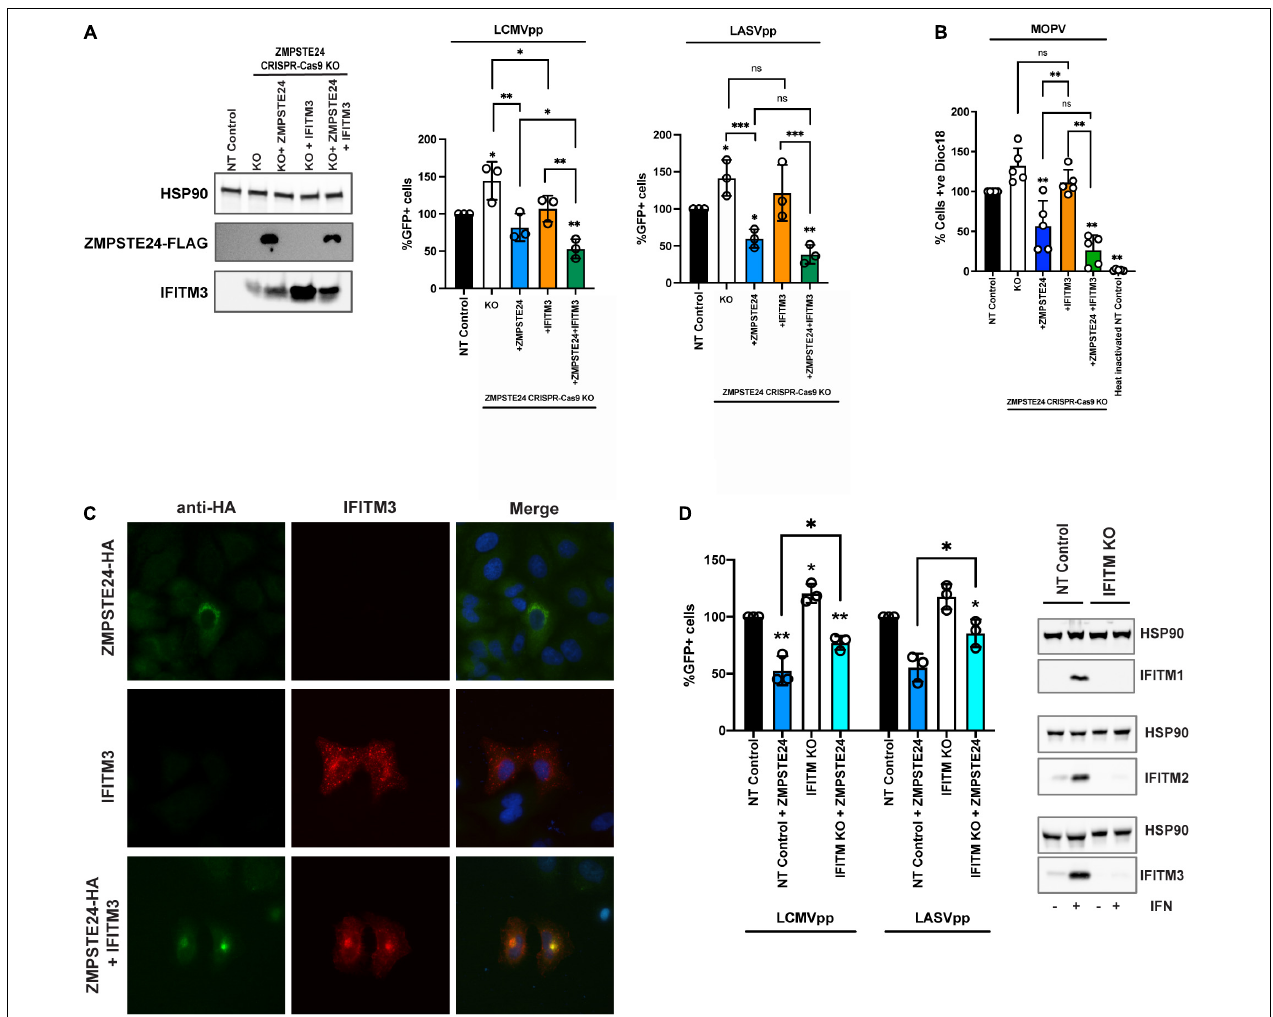
FIGURE 4 | ZMPSTE24 and IFITM3 co-operatively restrict arenavirus infection. (A) A549 CRISPR-Cas9 stable knock out cell lines were generated for non-targeting (NT) control or ZMPSTE24 and then transduced for stable overexpression of ZMPSTE24-FLAG or IFITM3 or both. Stable expression was confirmed by western blot cells were then infected with LCMVpp or LASVpp and% infection was measured by flow cytometry analysis of GFP expression. (B) Cells from panel A were infected with SP-DiOC-18 labelled MOPV for 1.5 h. SP-DiOC18 positive cells were measured by flow cytometry. (C) A549 cells were transiently transfected with HA-tagged ZMPSTE24 (green) and IFITM3 (red) and co-localisation was assessed by immunofluorescence microscopy. Nuclei were counterstained with DAPI. (D) A549 CRISPR-Cas9 NT control or IFITM KO cells were generated, and expression was assessed by western blot. Stable cells were then transduced express ZMPSTE24-FLAG and infected with LCMVpp or LASVpp. Infection was measured as %GFP positive by flow cytometry. Data are shown as mean ± SE (standard error) of n = 3 independent experiments. Significance is indicated as p -values *** p < 0.0001, ** p < 0.001, * p <